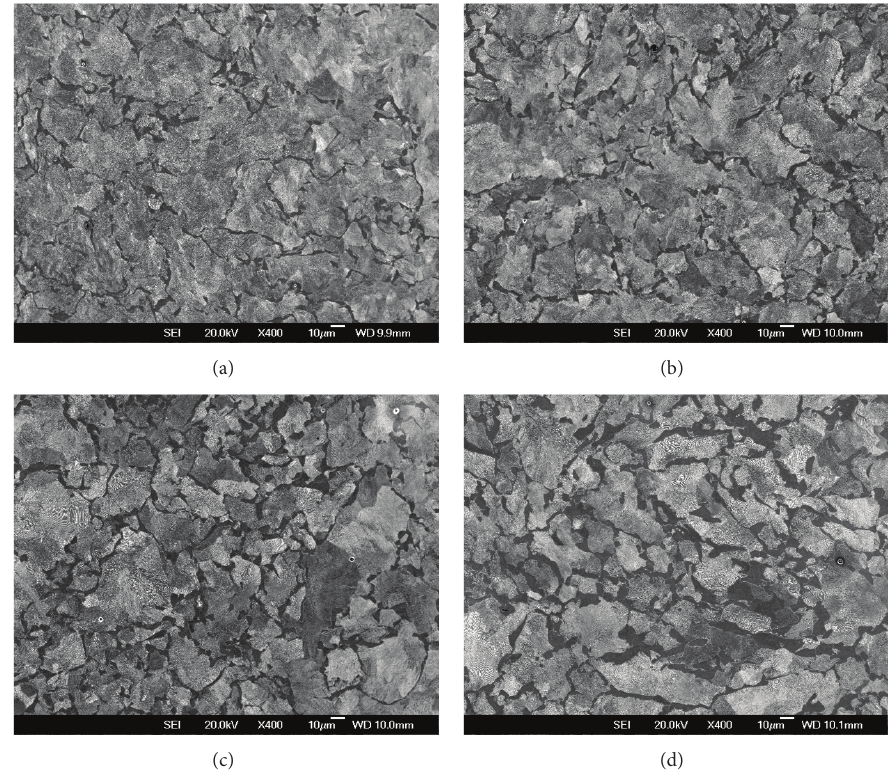
Figure 20: (a) SEM image of microstructure, Locn 1 on Figure 8. PE Ferrite 8.8%, 271HV. (b) SEM image of microstructure, Locn 2 on Figure 8. PE Ferrite 9.8%, 255 HV. (c) SEM image of microstructure, Locn 3 on Figure 8. PE Ferrite 16.9%, 237 HV. (d) SEM image of microstructure, Locn 4 on Figure 8. PE Ferrite 20.9%, 232